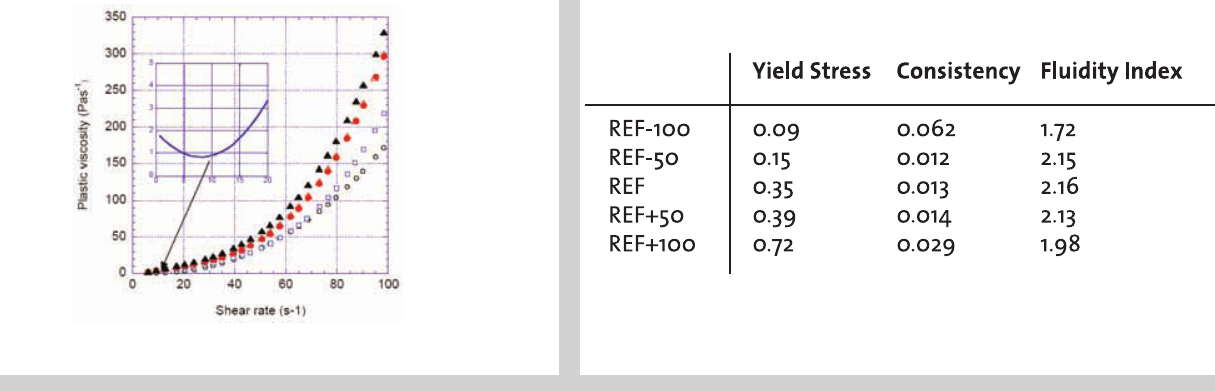
Figure 6 (left): Evolution of the plastic vis- cosity for different VMA con- tents ( Á : REF-100, · : REF-50, Ê : REF, Û : REF+50, Ú : REF+100). The inserted graph zooms in the behaviour of REF-100 at low shear rates. Table 4: steady state rheological parameters of